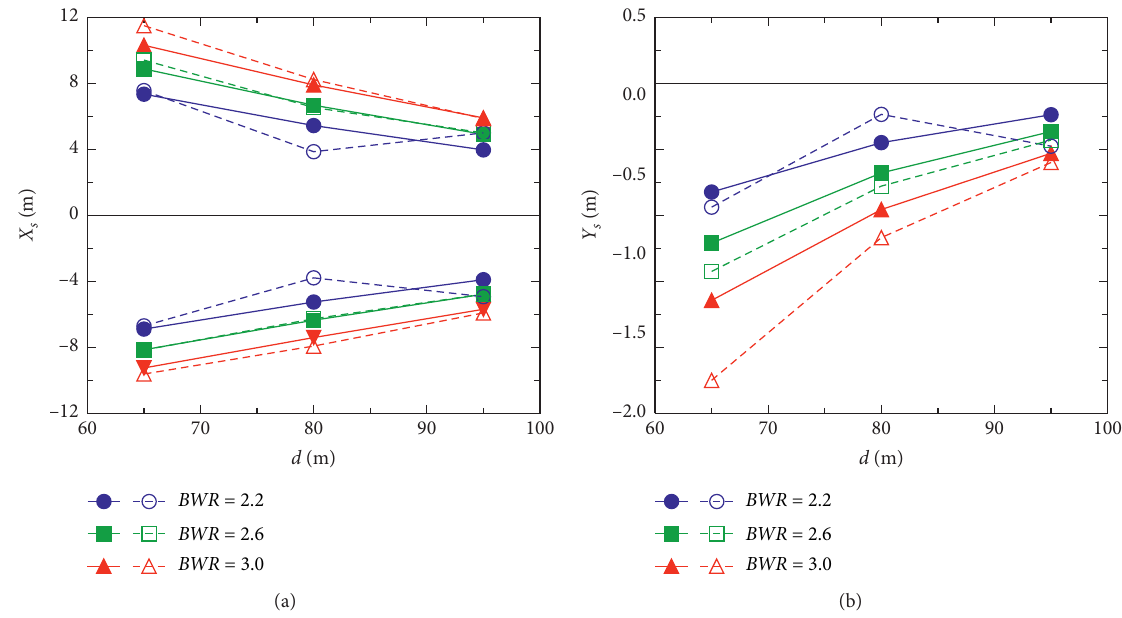
Figure 4: The average maximum value of (a) horizontal and (b) vertical tube displacements as a function of wave depth (d). Solid lines and solid markers are numerical simulation results; dotted lines and open markers are experimental data.